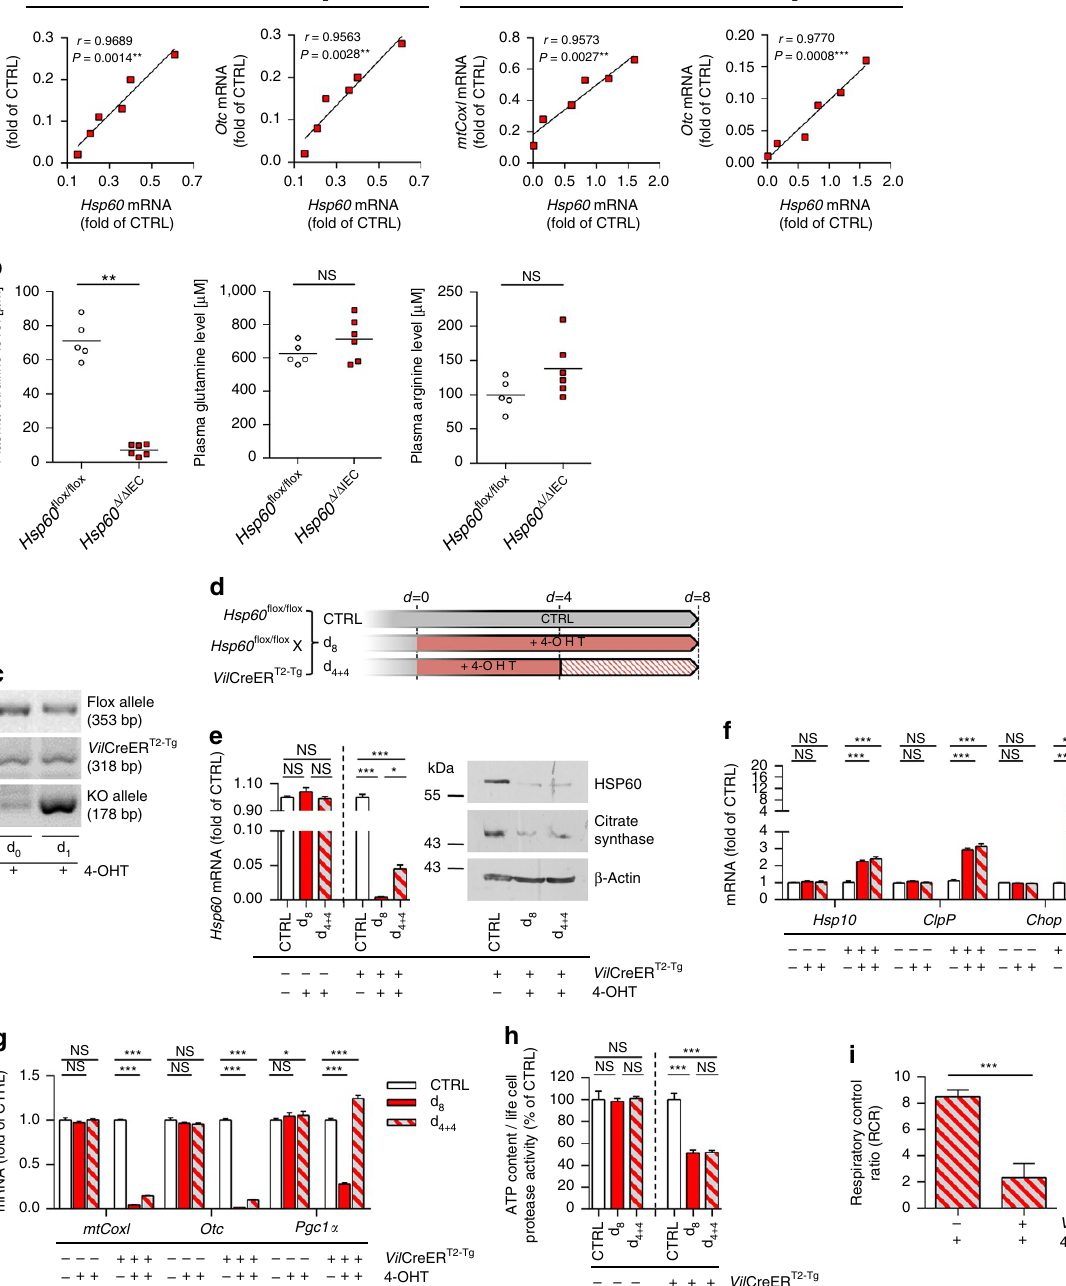
NATURE COMMUNICATIONS|7:13171|DOI: